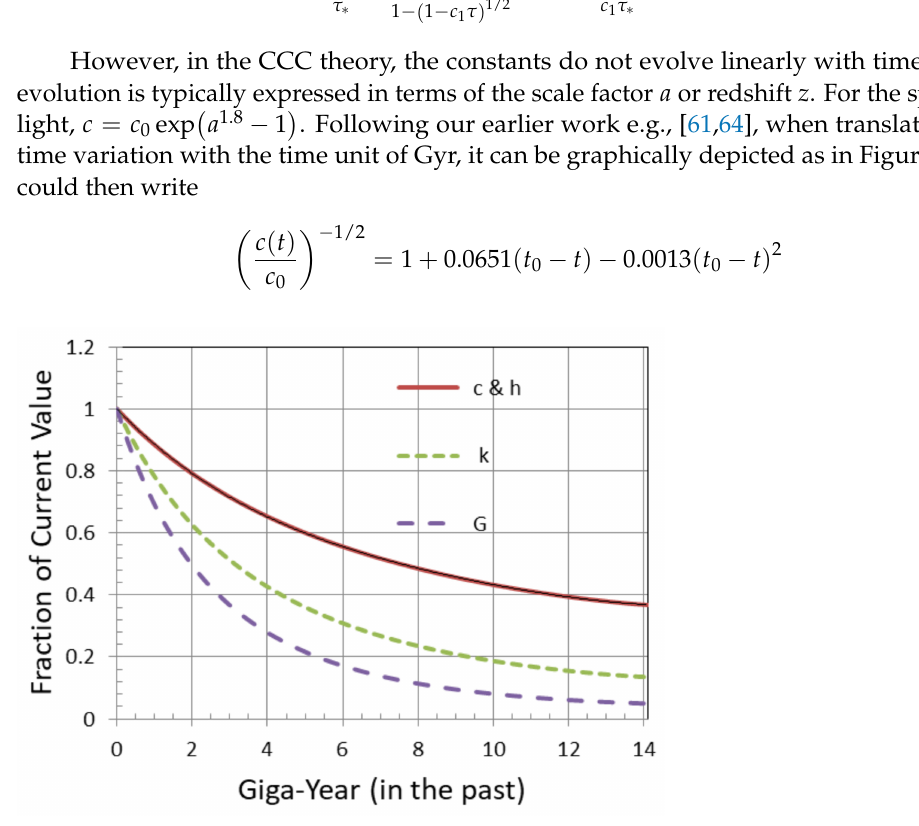
Figure 1. Variation of c , G , h , and k with cosmic time. Only c and h vary similarly. G and k vary differently. However, variations of all these constants are interrelated through a common function [59] and not arbitrfarily